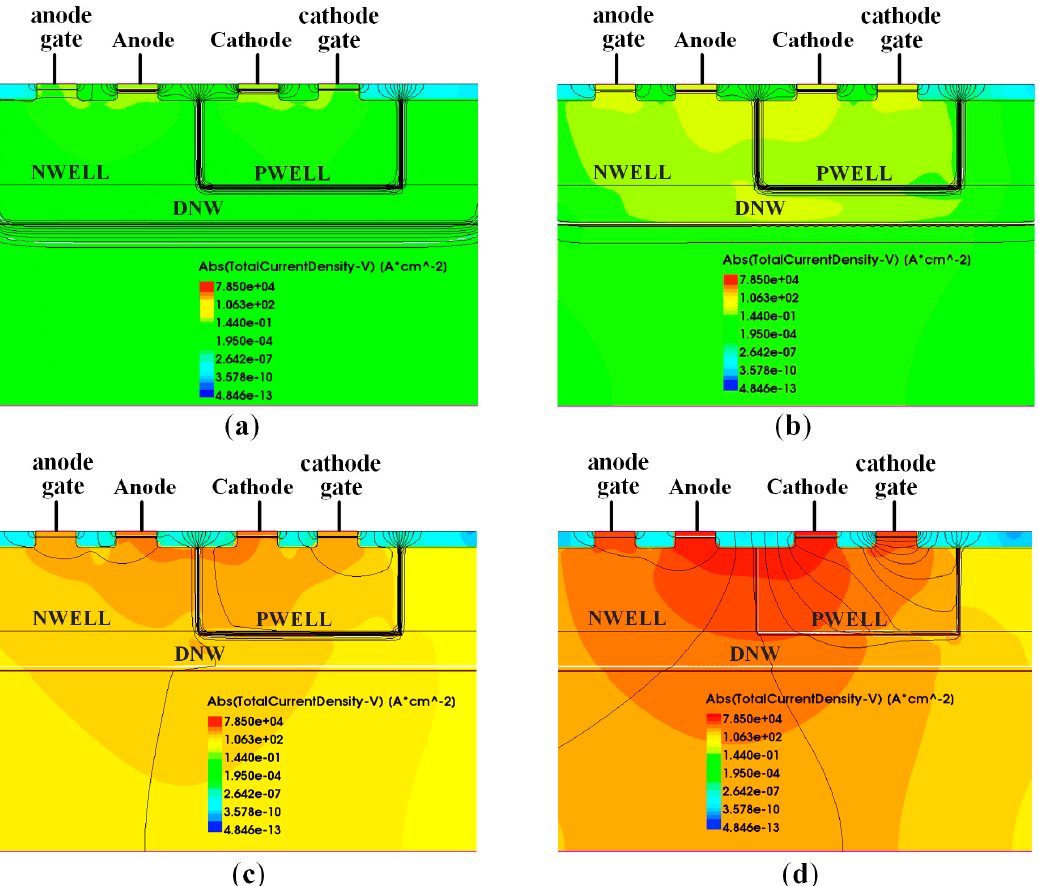
Figure 3. Total current density distributions at different current levels in DCSCR. ( a ) The trigger current flows along diode chain path; ( b ) the parasitic NPN and PNP transistors turn on; ( c ) the SCR path is triggered; and ( d ) the ESD current distribution after holding point.